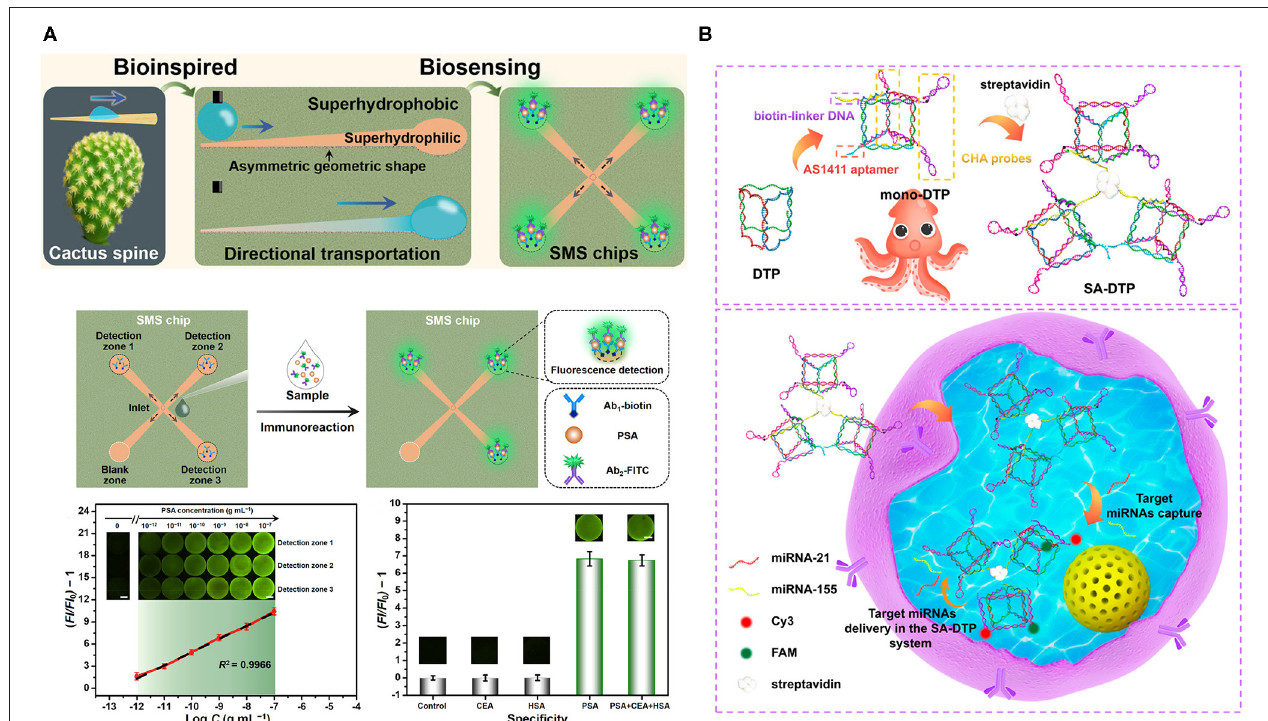
FIGURE 4 | (A) Directional droplet transportation on the superwettable microspine (SMS) chip inspired by the cactus spine. Sample [prostate-specific antigen (PSA)] with a detection antibody was loaded at the center and will transport to the detection zone, functionalized with a capture antibody, and the Ab1/PSA/AB2-FITC-generated fluorescence. Sensitivity of the SMS chip with increasing concentration of PSA. Specificity examination of the SMS by setting various conditions, including PSA, PSA + CEA + HAS, HAS, carcinoembryonic antigen (CEA), and negative control (Chen et al., 2020). (B) A schematic of fabrication of the SA-DTP, biotin-linker DNA, AS1411 aptamer, and catalytic hairpin assembled (CHA) probes were connected by streptavidin. Below is the multiplex detection of RNA in the living cells ( Yang F. et al., 2020). All copyright 2021 American Chemical Society.